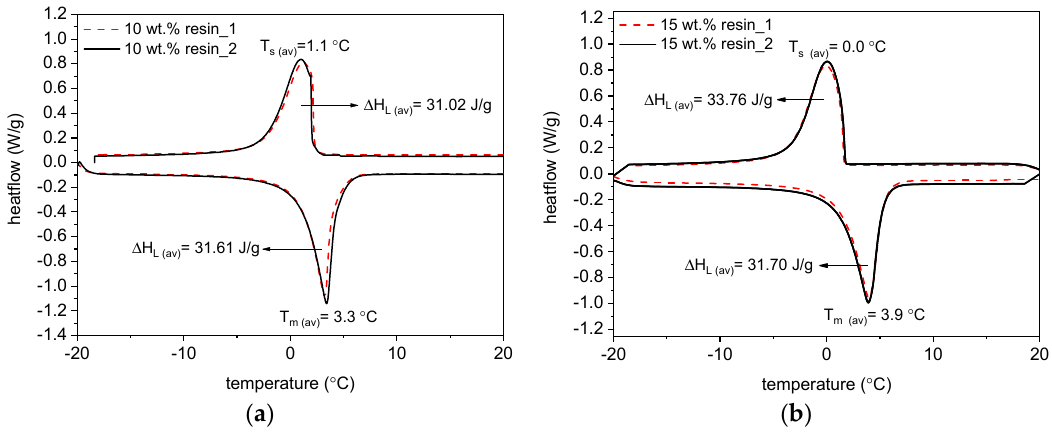
Figure 8. DSC tests of ME-LWAs samples from − 20 °C to +20°C coated with ( a ) 10 wt % resin and ( b ) 15 wt % resin.